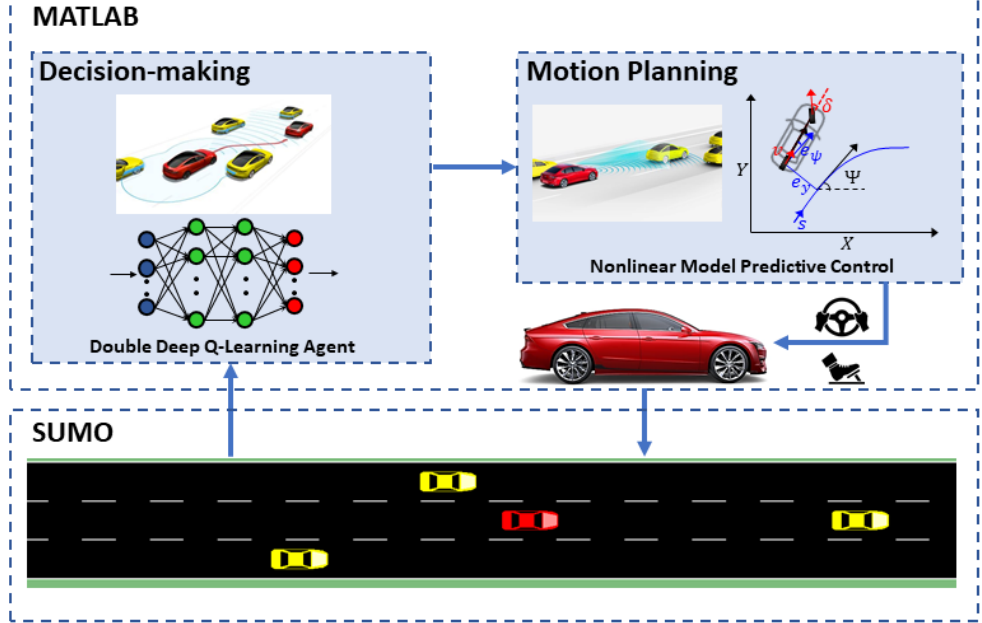
Figure 2. Hybrid Hierarchical decision-making and motion planning control architecture. The proposed solution driving the motion of the Ego-vehicles runs on the MATLAB Platform, while the interactions between the ego vehicle and the other road entities are emulated by exploiting